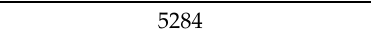
Table A4. The result of the query “Long Response